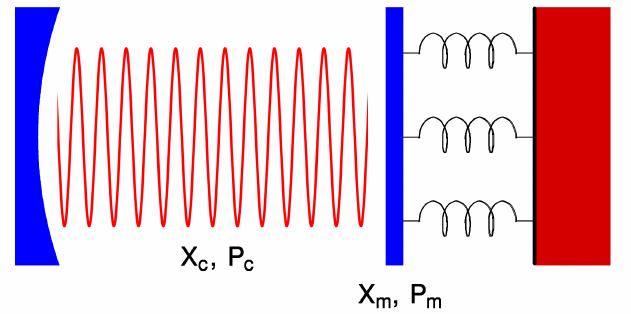
Figure 1: Schematic of the nanomechanical resonator coupled to a cavity